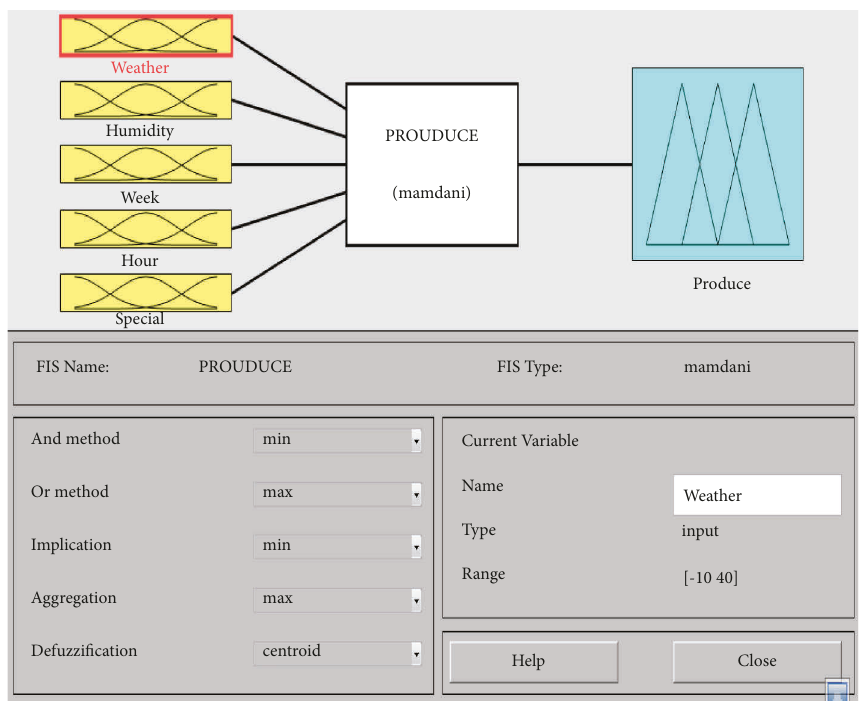
Figure 2: View of input and output variables in the MATLAB fuzzy variable